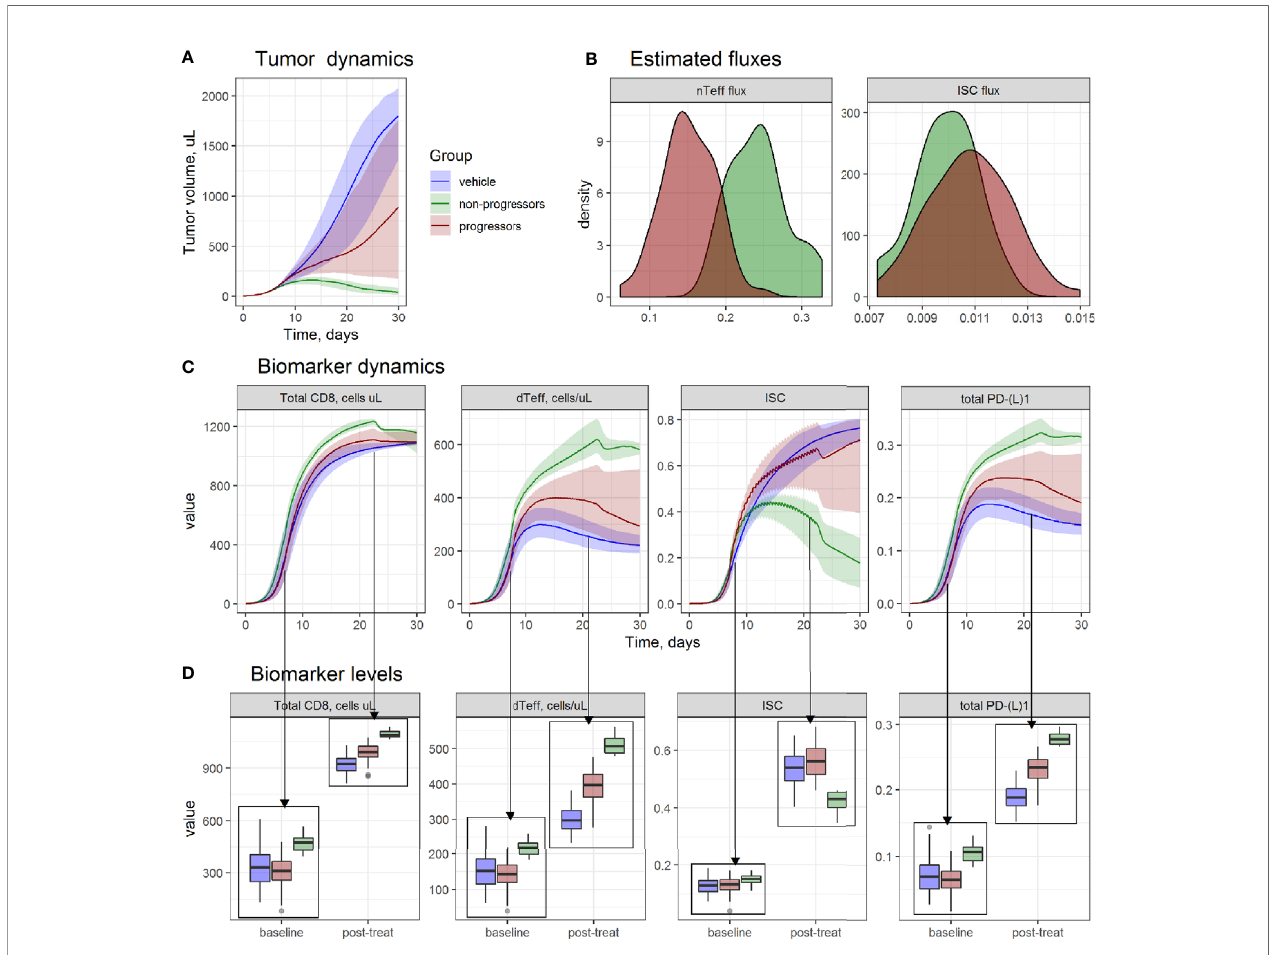
FIGURE 3 | Evaluation of tumor microenvironment (TME) differences between progressors (red), non-progressors (green), and animals from vehicle group (blue), from MCA205 study 1. (A) Simulated tumor size dynamics. Lines — median prediction, area — 90% prediction interval (PI). (B) Density of simulated model parameters. (C) Simulated dynamics; and (D) boxplots of TME components at baseline and on day 14 th day of